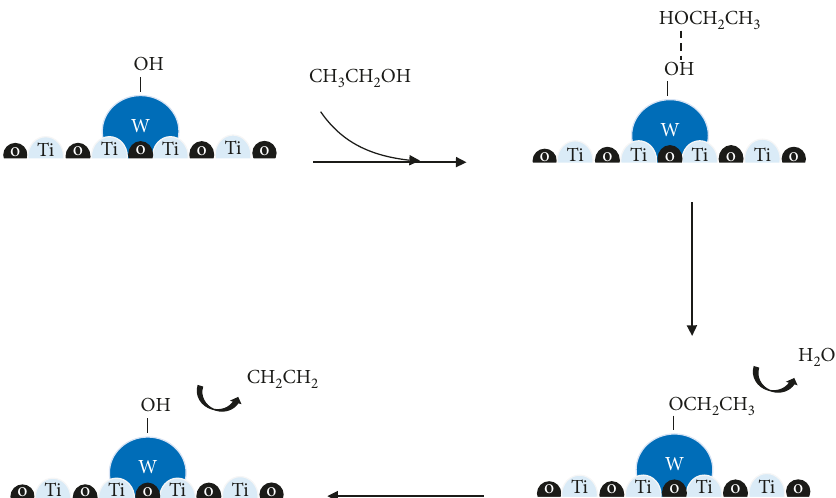
Scheme 1: Ethanol dehydration to ethylene over WO